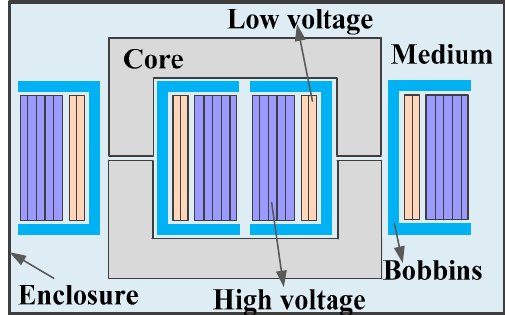
Figure 1. 2 ‐ D schematic diagram of a typical high ‐ frequency (HF) transformer. Figure 1. 2-D schematic diagram of a typical high-frequency (HF)